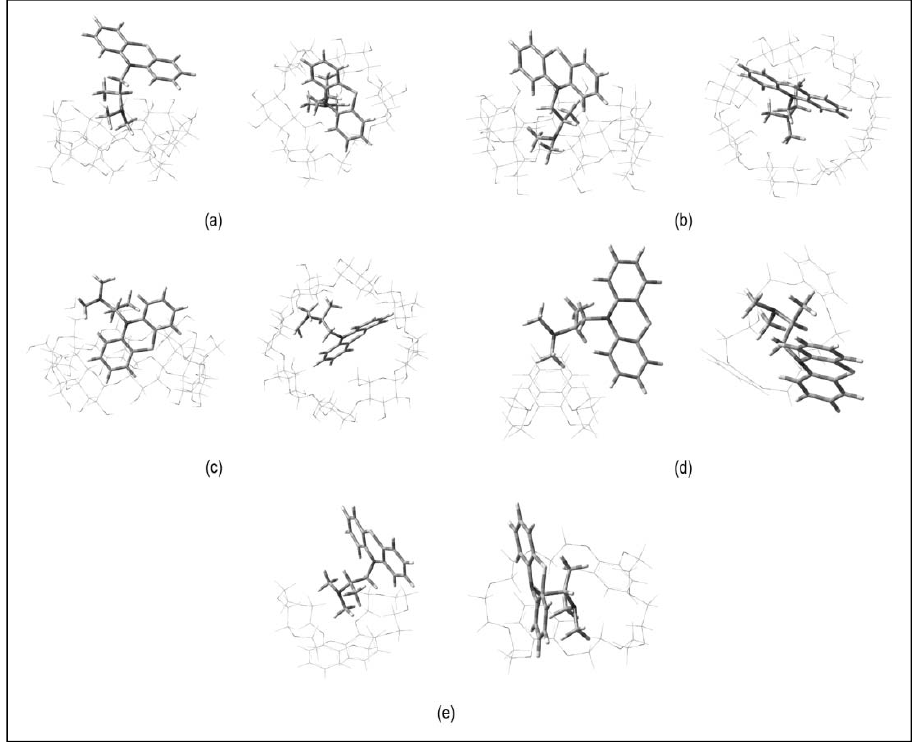
Figure 6. The energy minimised structures obtained from PM3 calculations for the side and top view of (a) promethazine/ α -CD, (b) promethazine/ β -CD, (c) promethazine/ γ -CD, (d) promethazine/DB18C6, and (e) promethazine/DB30C10